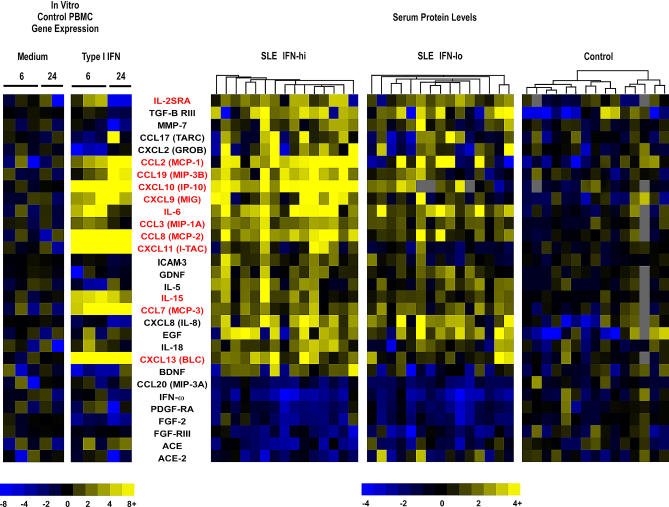
Coordinate Dysregulation of Serum Protein Levels in SLEHierarchical clustering was applied to protein levels of the identified analytes (“Serum Protein Levels”). Individual data points represent the log2 ratio of the analyte concentration to the mean of control concentrations (scale shows linear fold-differences). “In Vitro Control PBMC Gene Expression” columns present gene expression microarray data obtained by incubating normal control PBMCs in vitro with medium alone or with type I IFN for 6 and 24 h. Data are normalized to control medium-alone conditions (scale depicts linear fold-differences). Grey boxes indicate missing data. Analytes induced by type I IFN in vitro (>2-fold and >500 expression unit mean difference) are highlighted in red font.